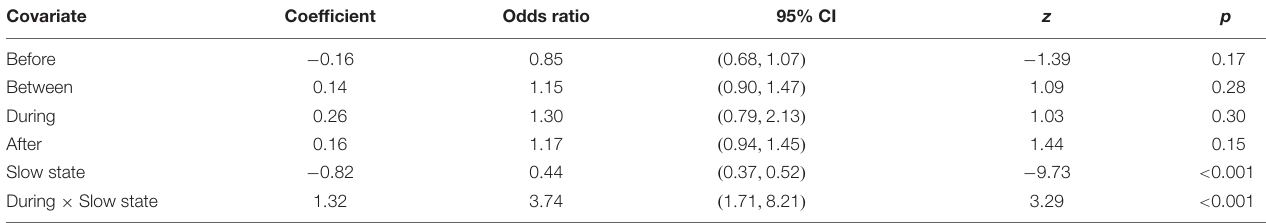
TABLE 3 | Estimates from a Cox proportional hazards model assessing the effect on sonar exposure phase and movement state on the cessation of calling. Covariate Coefficient Odds ratio 95% CI z p